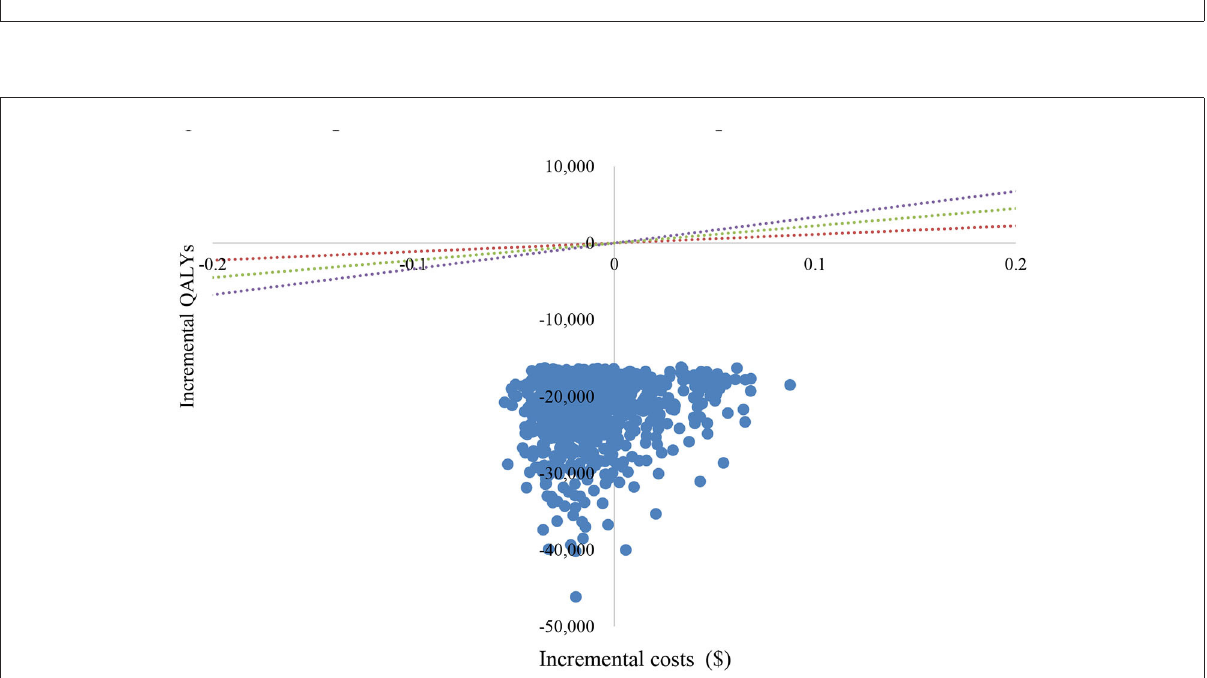
FIGURE4 Scatter plot of incremental cost-effectiveness plane. QALY, quality-adjusted life